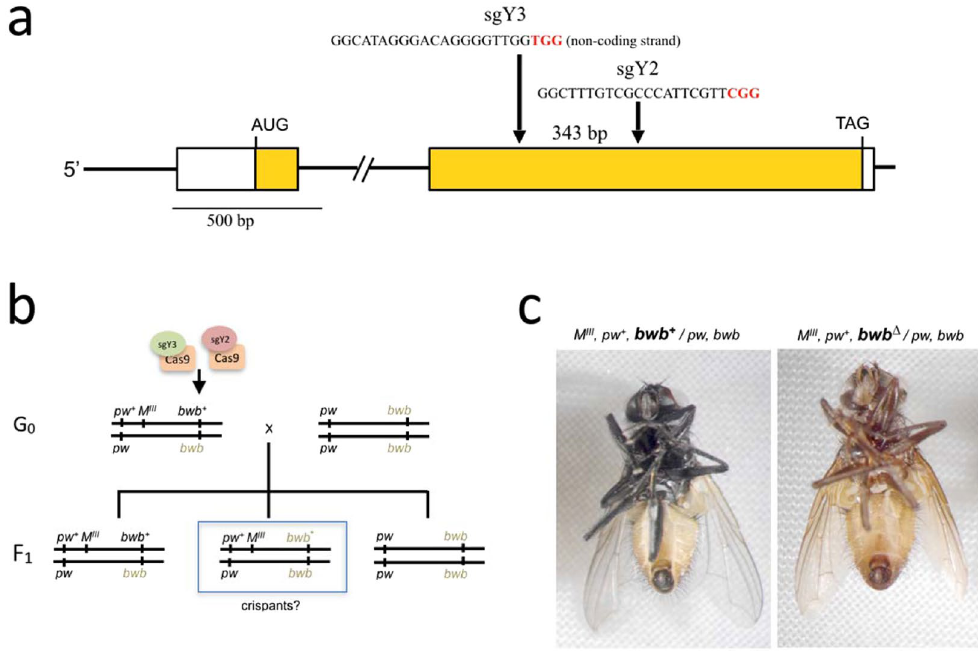
Figure 2. Strategy for CRISPR/Cas9 mediated disruption of MdY . ( a ) A schematic of the MdY gene showing the positions of the two target sites in exon 2. Sequences used for the design of the two sgRNAs, sgY3 and sgY2, are indicated. Both sequences are flanked by a PAM motif (in red) and separated by 343 bp. ( b ) Crossing scheme for screening mutational events affecting melanization. Injected G 0 males (with a mix of sgY3-CAS9 and sgY2- CAS9) are crossed with bwb females and F1 is examined for occurrence of bwb males. ( c ) Right a bwb mutant F1 male from line MdY#16 which is heterozygous for a CRIPSR induced 10 bp deletion in sgY3 over MdY b . Left an unaffected bwb wildtype F1 male from the same line with the paternal genotype ( MdY + over MdY b ).